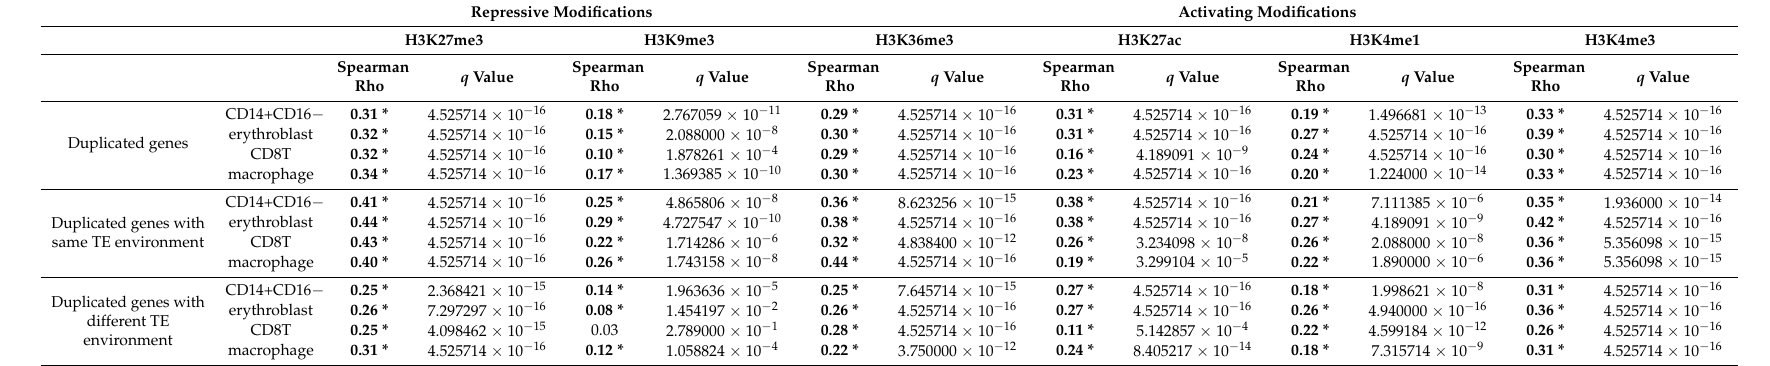
Table 3. Correlations of the histone enrichment between paired